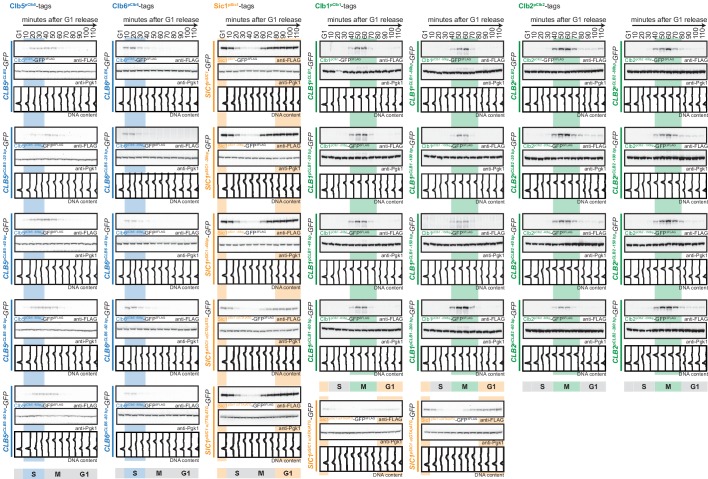
5'UTR truncations and upstream out of frame ATGs do not interfere with cell cycle restriction.Western blot analysis of Clb5pClb5-, Clb6pClb6-, Clb1pClb1-, Clb2pClb2- and Sic1pSic1-tagged GFP expressed from 33 constructs with truncated 5’UTR or upstream out of frame ATGs during a single cell cycle. Cells were arrested in G1 and synchronously released to the cell cycle up to the next G1 as in Figure 1B. Anti-FLAG western shows cell cycle-tagged constructs, anti-Pgk1 western is used as control. Bottom: DNA content measurement by flow cytometry.